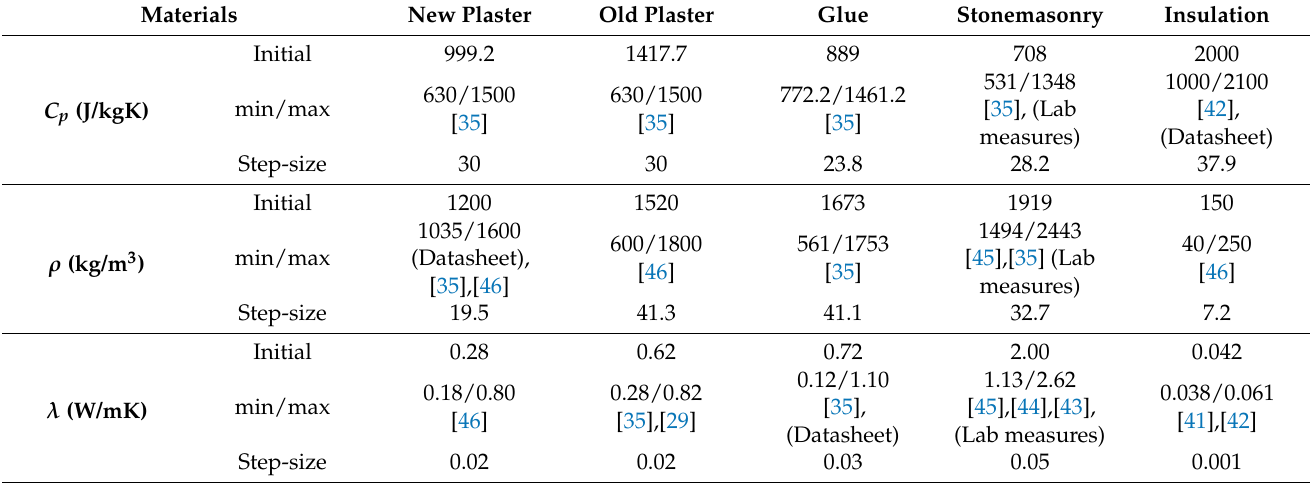
Table 2. Range of variation of material